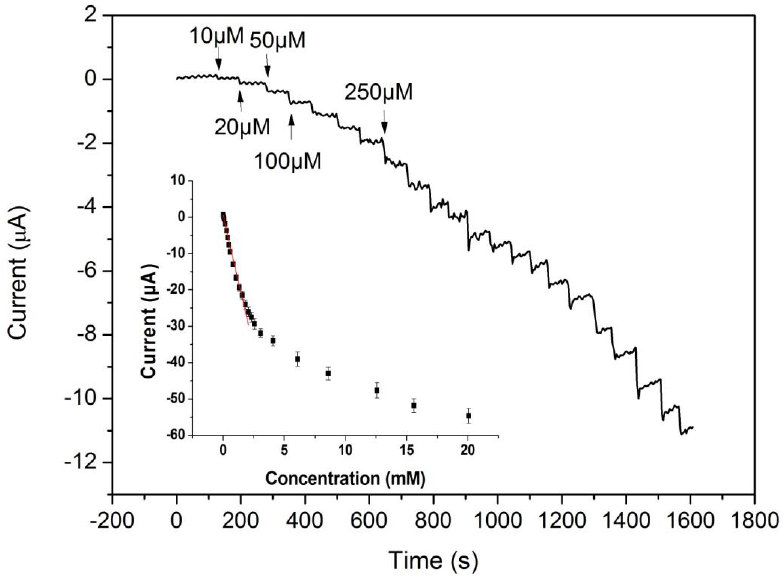
Table 1. Comparison of performance of H